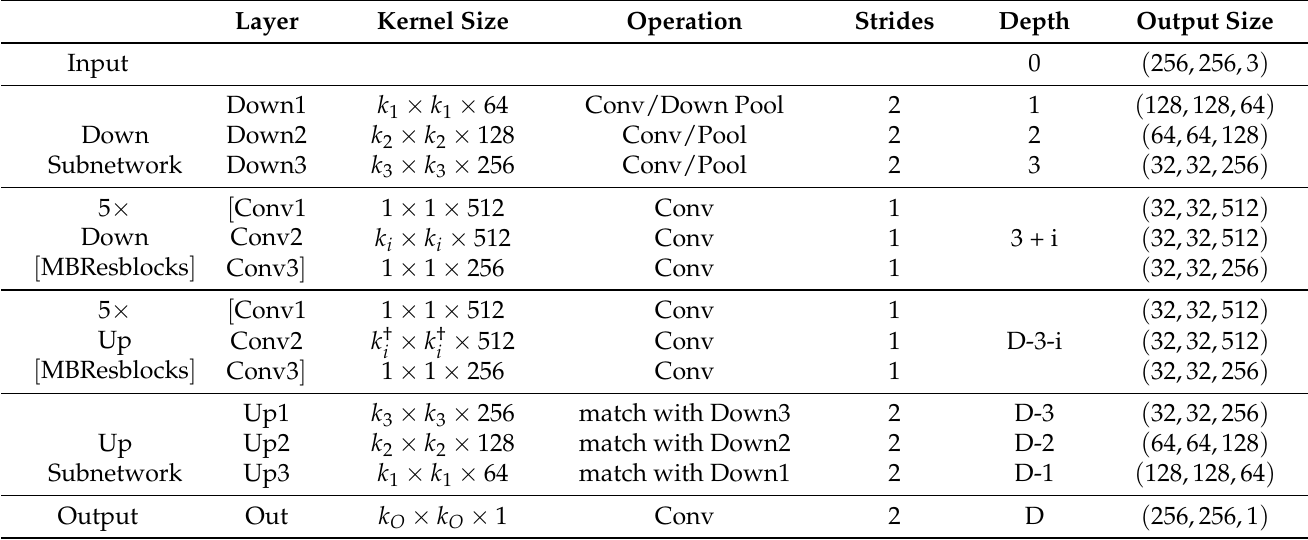
Table 1. Details of network structure. D is the total depth of Unet and D = 17 in our experiments. i is the # of Down MBResblocks in Unet and i = 1,2,3,4,5. k †